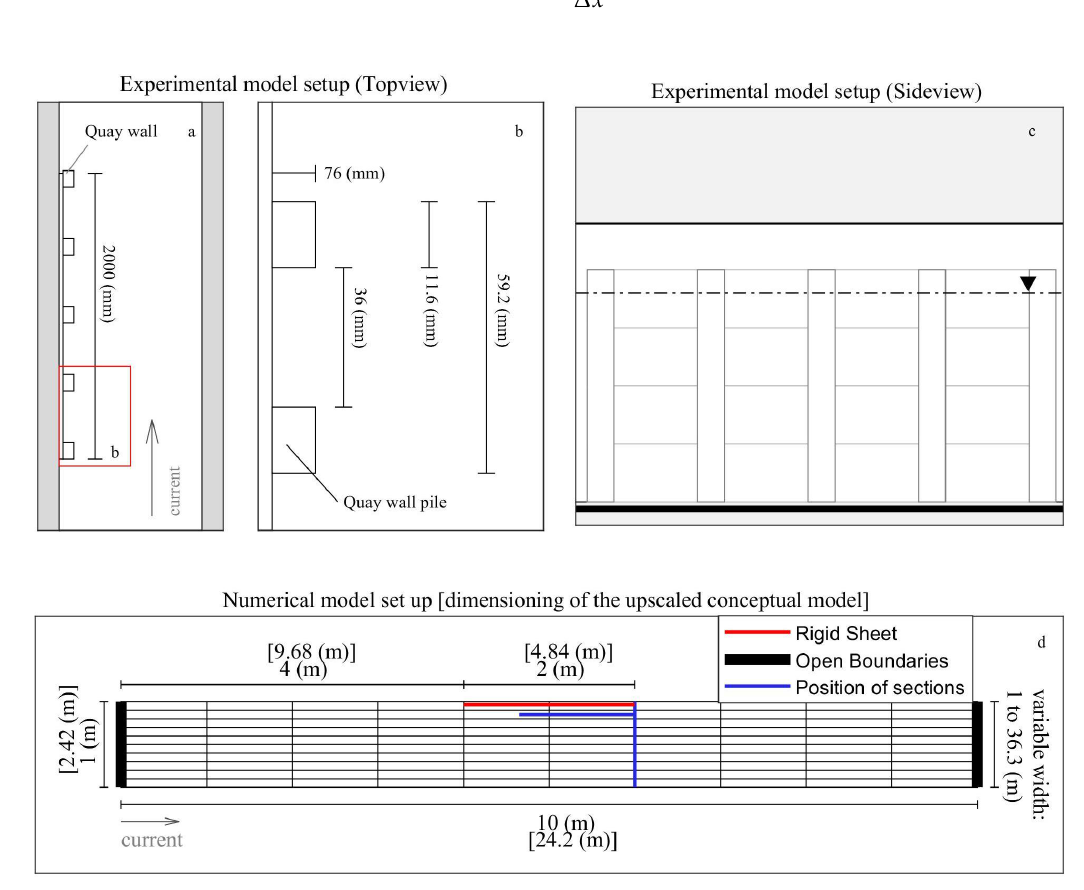
Figure 4. Dimensions of the experimental model for ( a ) dorsal view, ( b ) detailed top down and ( c ) frontal view. The numerical flume model (NFM) ( d ) top-down for calibrating the roughness coefficient c loss with positions of measured